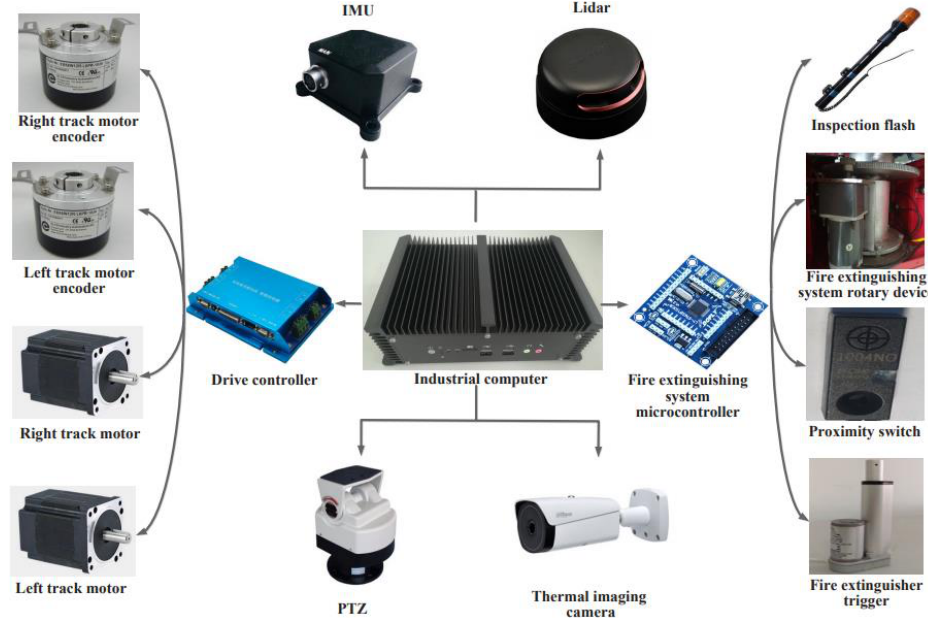
Figure 4. Schematic diagram of the robot’s hardware system architecture.